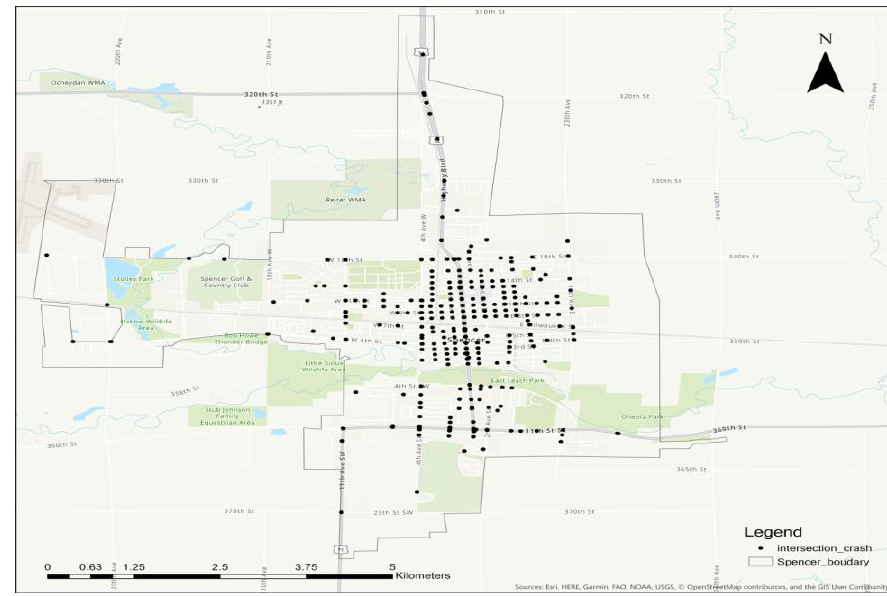
Figure 8. Distribution of crashes in Spencer city.